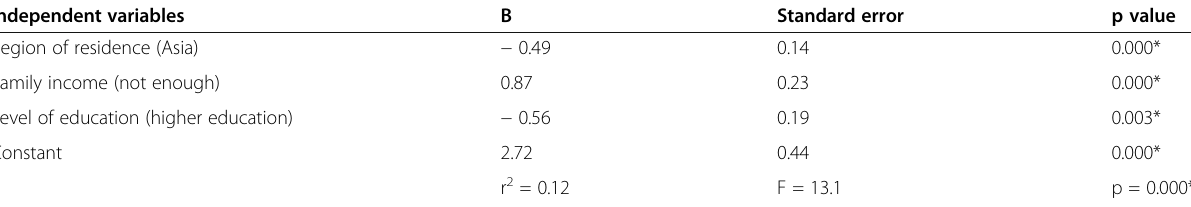
Table 5 Linear regression analysis of the factors predicting the number of IPV types to which adult Arab women exposed to during the COVID-19